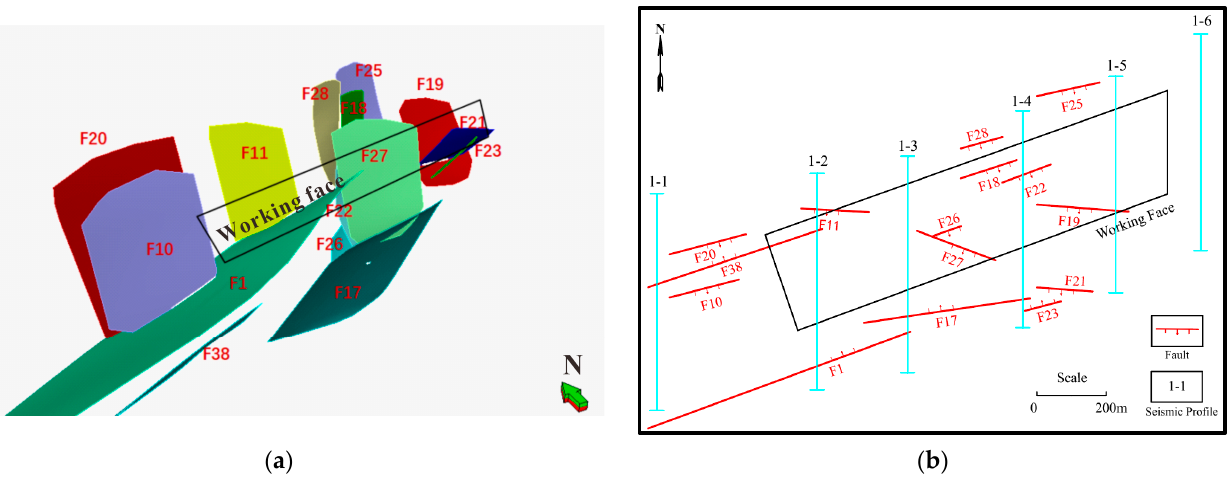
Figure 10. Distribution of faults near the working face: ( a ) Three-dimensional distribution of faults; ( b ) Fault plane distribution and location of seismic profiles.